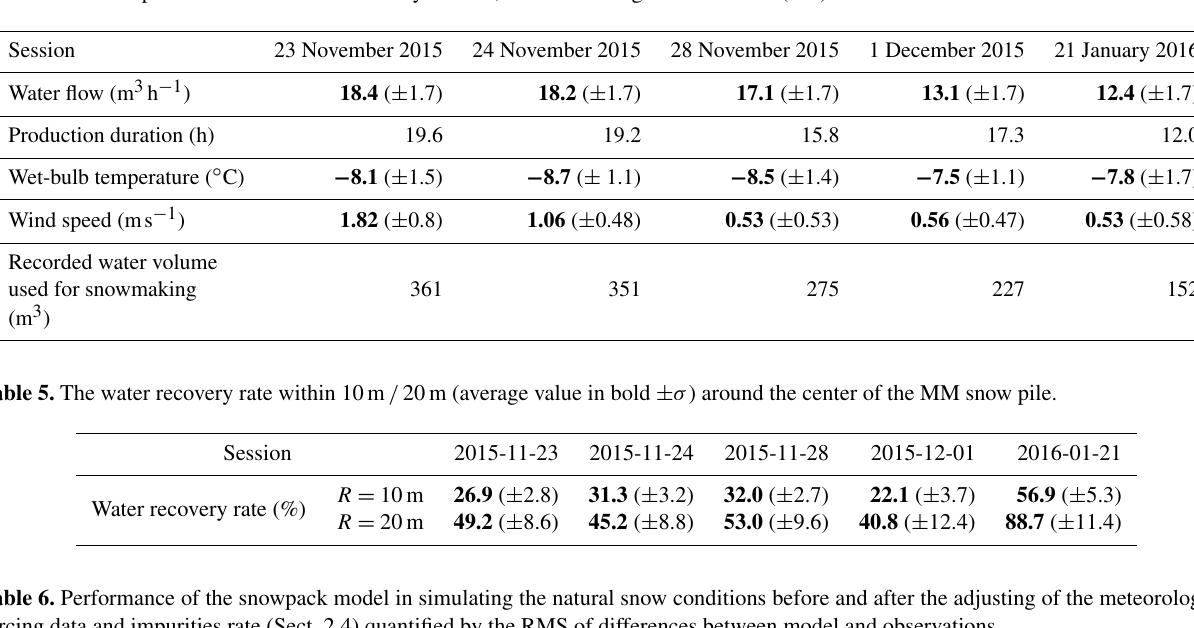
Table 4. Detailed production conditions for every session, with the average value in bold ( ± σ ).